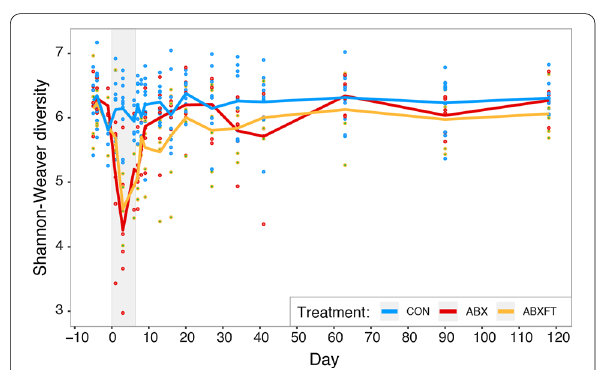
Fig. 2 Shannon–Weaver alpha diversity over time in three experimental groups of male ring‑tailed lemurs ( Lemur catta ). Shown are values for healthy animals that received no treatment (CON), antibiotics only (ABX), or antibiotics plus fecal transfaunation (ABXFT). Dots represent individual data points and lines connect the mean values of alpha diversity across individuals at each time point. The shaded window represents the period of antibiotic treatment (days 0–6), with fecal transfaunation administered on day 7; all values prior to the onset of treatment represent baseline values and all values post‑treatment represent the period of recovery